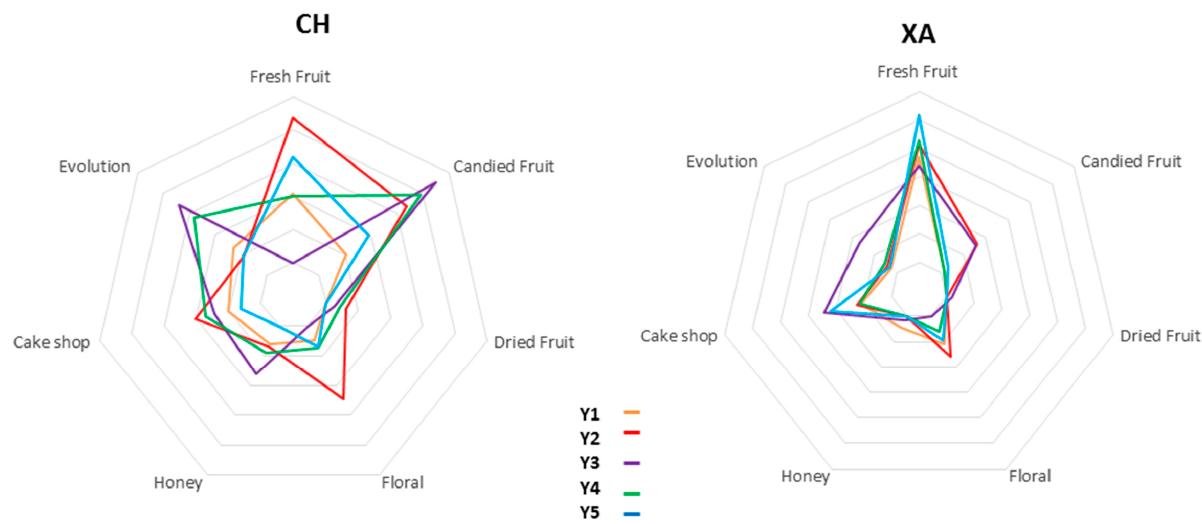
Figure 3. Aromatic profiles of the cavas obtained after 18 months of aging on lees, of the Chardonnay (CH) and Xarel.lo (XA) varieties made with five different yeasts strains (Y1, Y2, Y3, Y4, Y5). Results obtained by the mean and standard deviation of the scores given by the tasters.